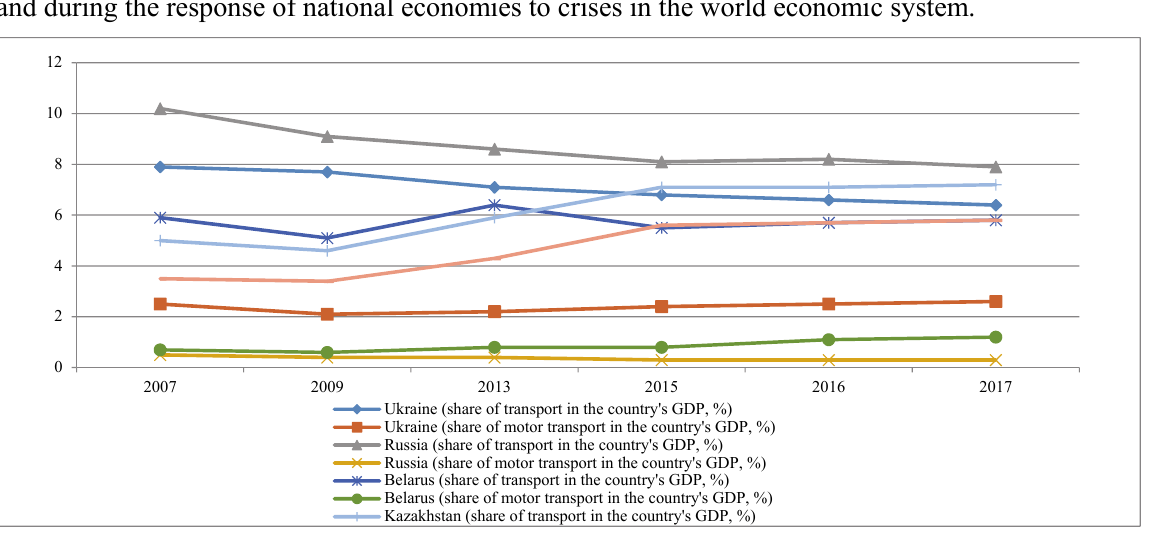
Fig.1. Dynamics of the share of the transport industry and its motor transport sector in the GDP of key countries in the post-Soviet economic space in